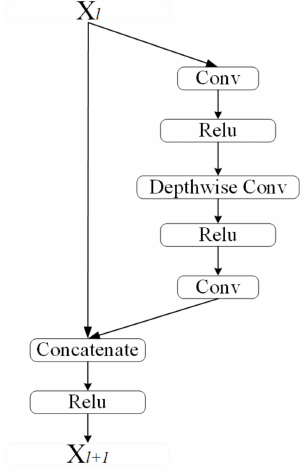
Figure 3. Detailed structure of Resblock.